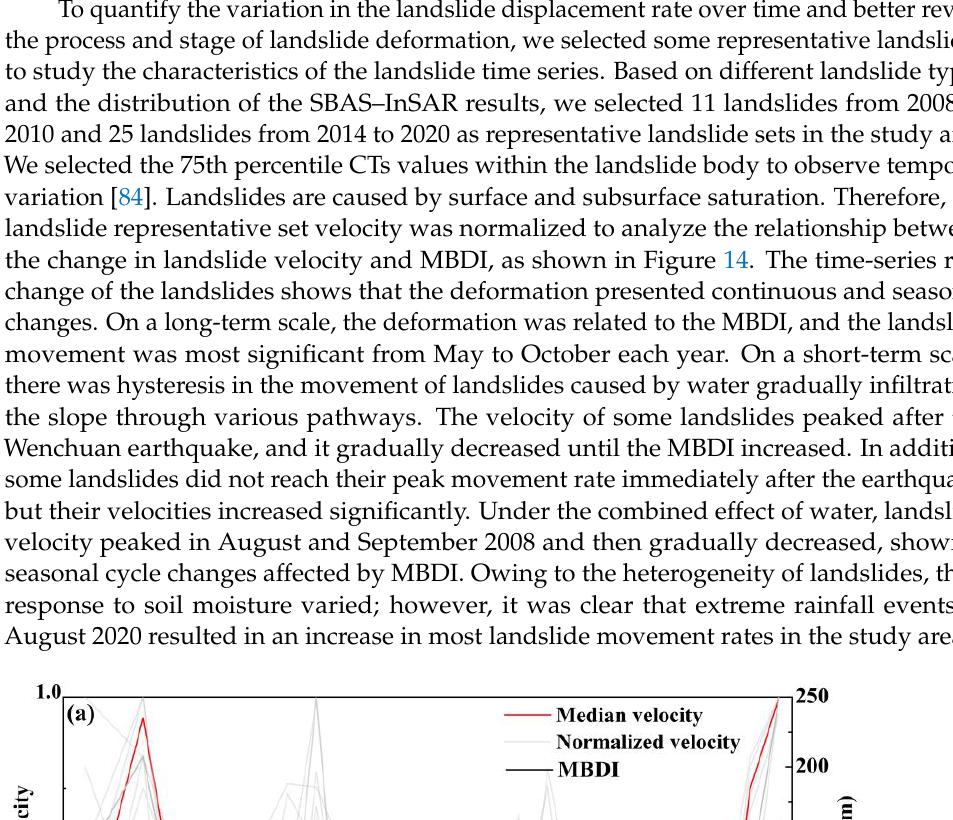
Figure 13. Number of landslide activity types in different years.